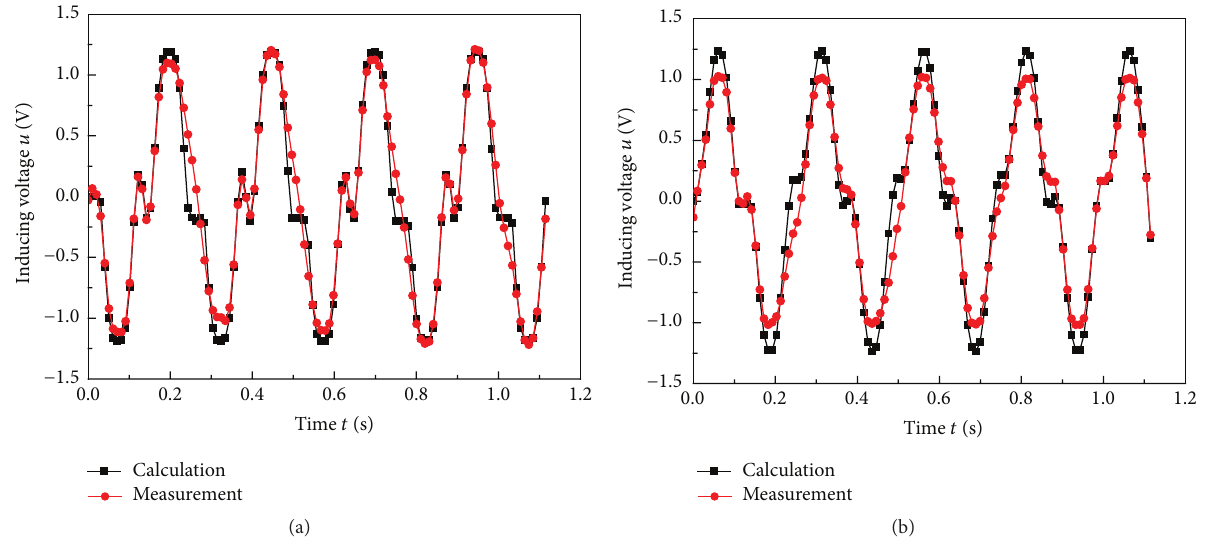
Figure 14: Comparison between numerical analysis result and experimental test of inducing voltage: (a) coil A and (b) coil